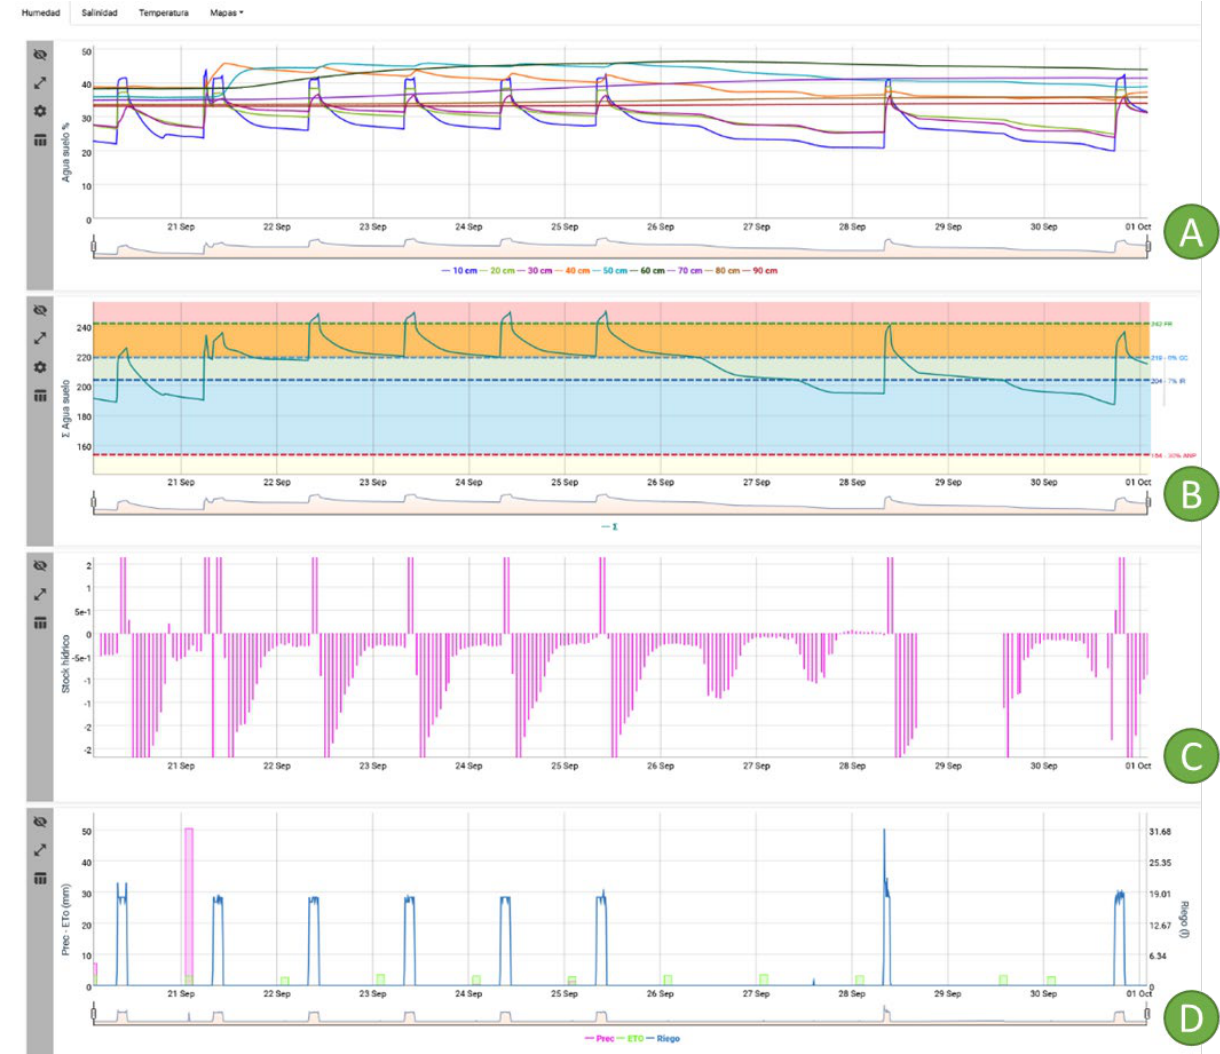
Figure 18. Evolution of the soil volumetric water content at different depths (10 to 90 cm) in the adult lemon tree crop ( A ). Sum of the volumetric water content in the soil at the depths of maximum root density ( B ). Variation of the volumetric water content in the soil for two consecutive time instants ( C ). Values of water applied through irrigation, evapotranspiration of the reference crop and rainfall during the period shown from 20 September to 1 October 2021 ( D ).